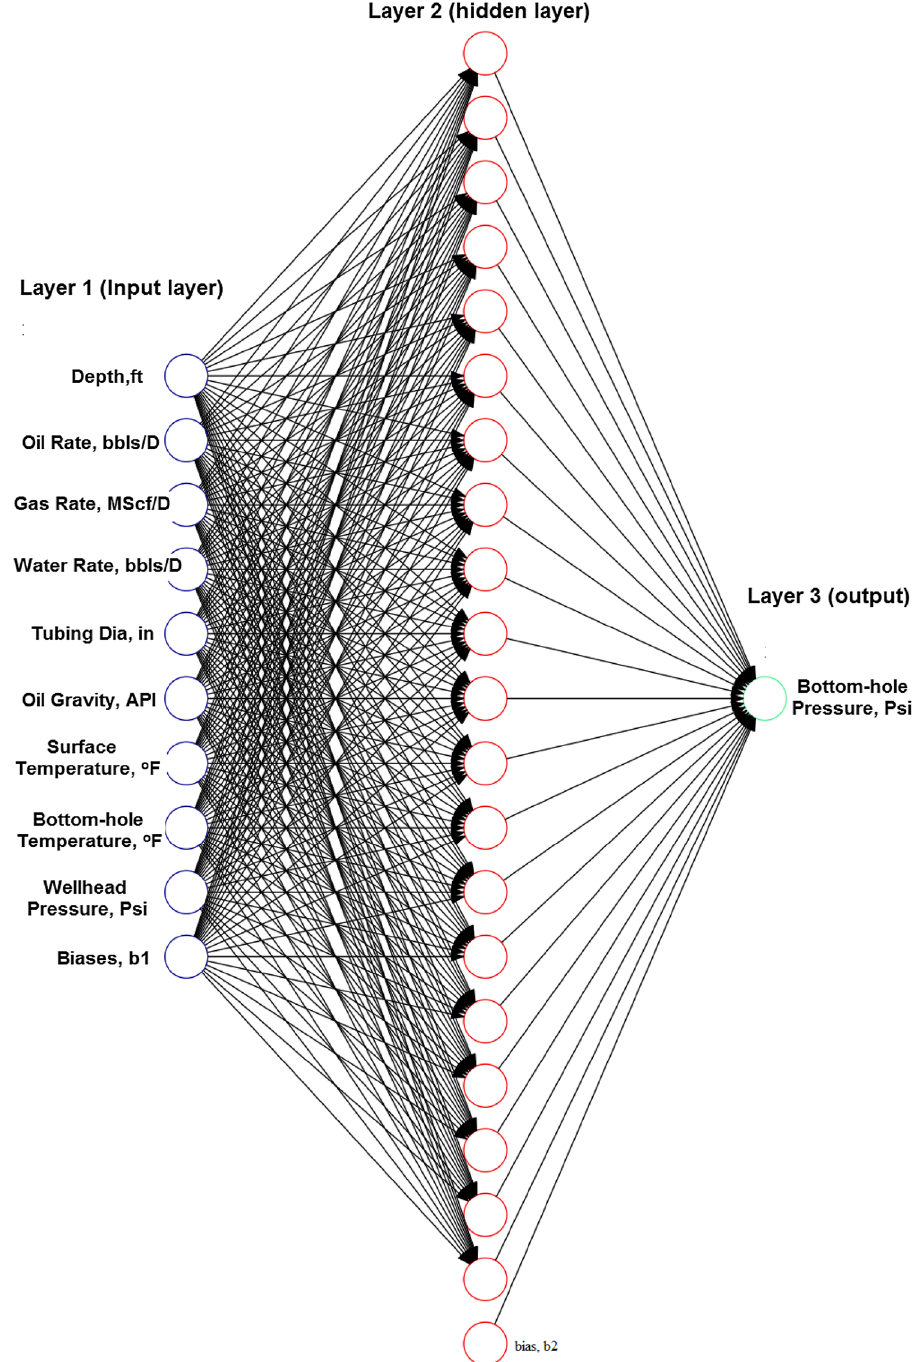
Fig. 7 Architecture of